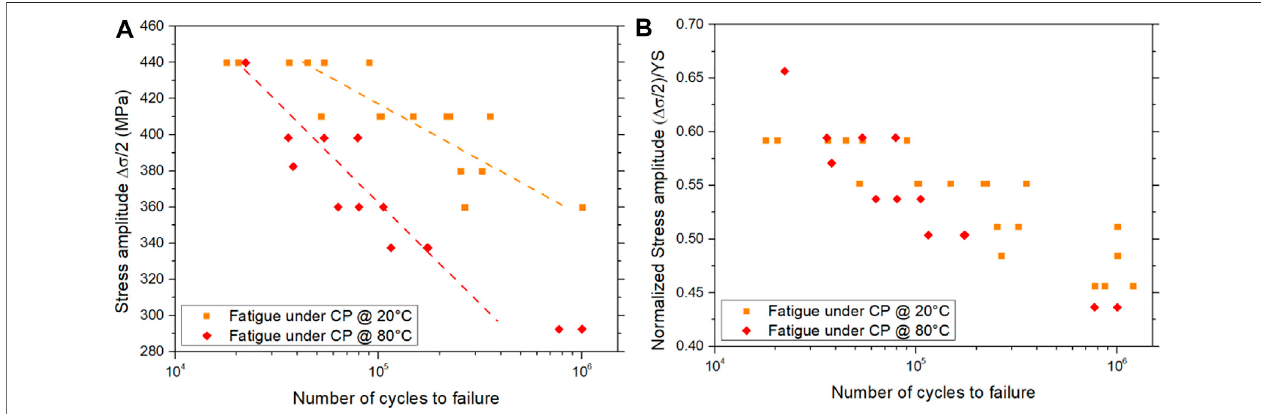
FIGURE 7 | (A) SN curves obtained at 20 ° C and 80 ° C and (B) normalized by the YS of the SDSS 1 at the tested temperatures.